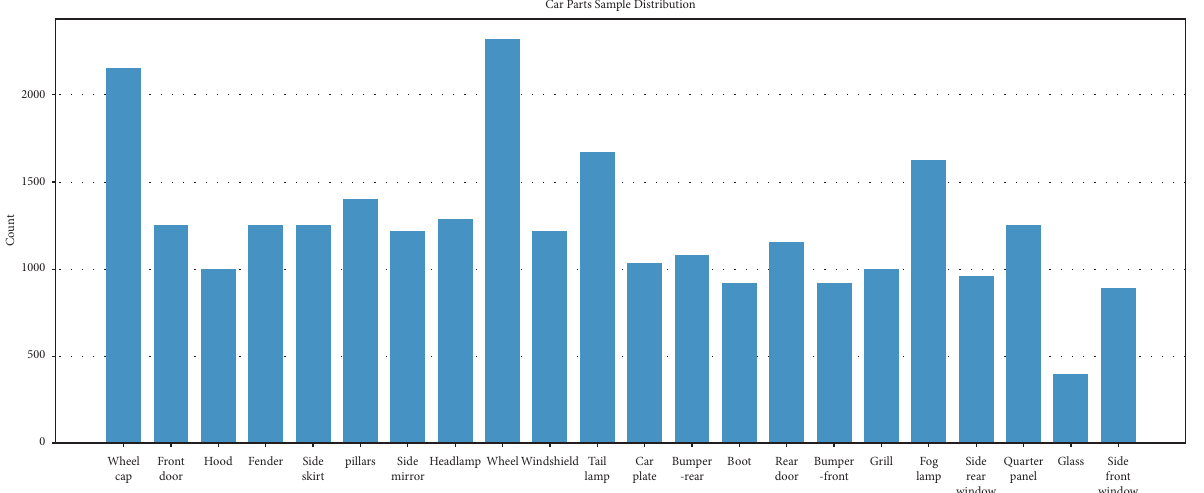
Figure 8: Distribution of various car part types merged in the dataset including 22 diferent